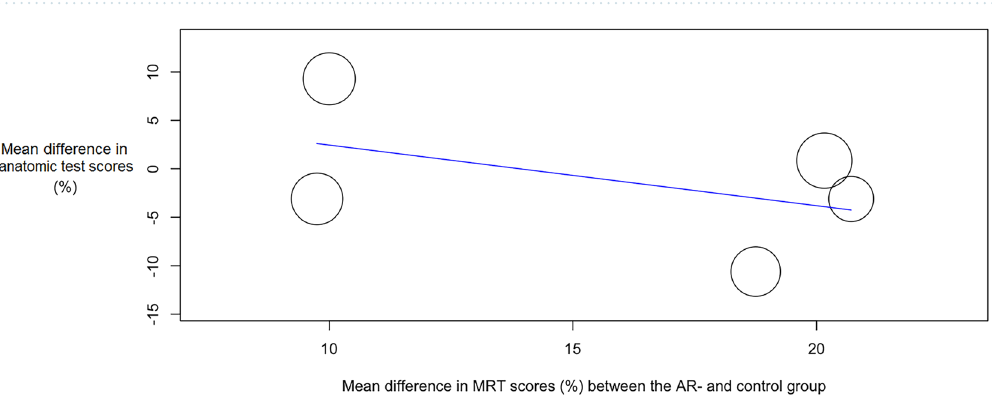
Figure 4. Bubble plot with fitted meta-regression line of mean difference in anatomic test scores (%) and spatial ability. Included are the studies addressing AR vs. 2D forms of anatomical education (i.e., traditional anatomical atlases, radiological data). AR augmented reality, MRT mental rotation